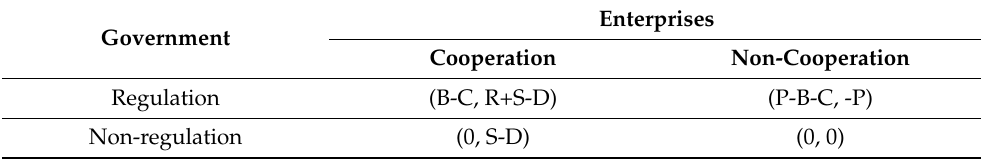
Table 1. Game matrix between the government and